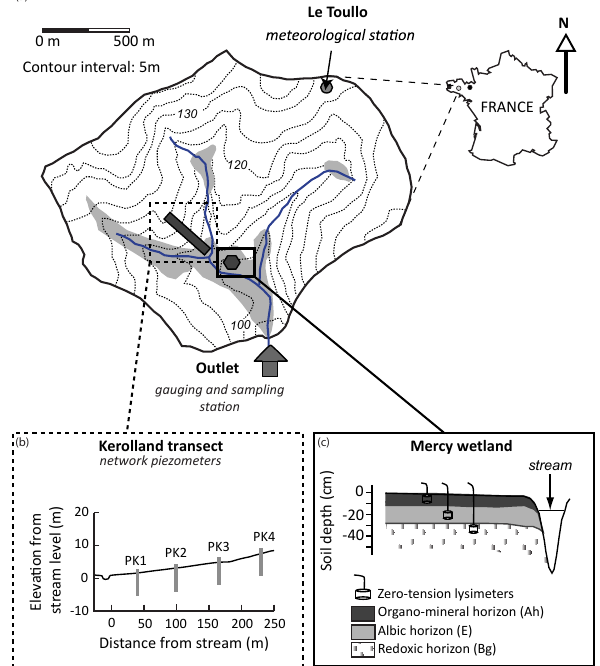
Figure 1. (a) Location and geomorphic map of the Kervidy-Naizin experimental catchment (Brittany, France). Also shown are the sites where the instruments used in this study are installed. Grey areas located along the stream channel network indicate the maximum extent of the interaction zone between the organo-mineral horizon of the soils and the upper layer of the groundwater. (b) Piezome- ter transect in Kerolland site. (c) Location in the soil profile of the soil water samples previously analysed and discussed by Lambert et al. (2013). Names of soil horizons in bracket refer to the IUSS Working Group WRB (2006)